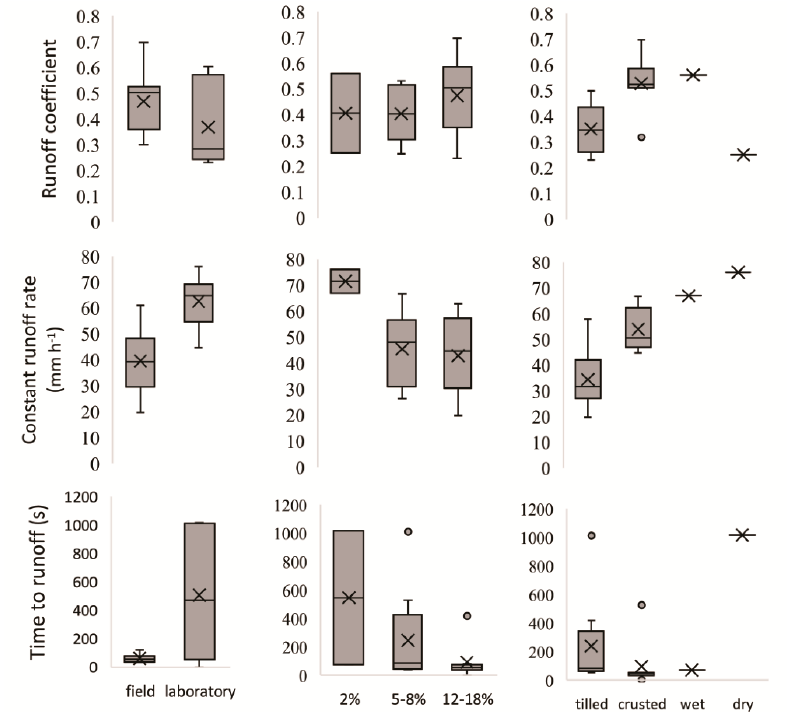
Figure 4. Comparison of the runoff coefficients, constant runoff rates (mm h − 1 ), and time to runoff (s) in accordance with the location, slope gradient, and surface moisture content/roughness. Boxes represent the interquartile interval, the black line in the middle is the median, and the x is the average; the whiskers indicate 1.5 × the interquartile interval. Values outside this are considered outliers.